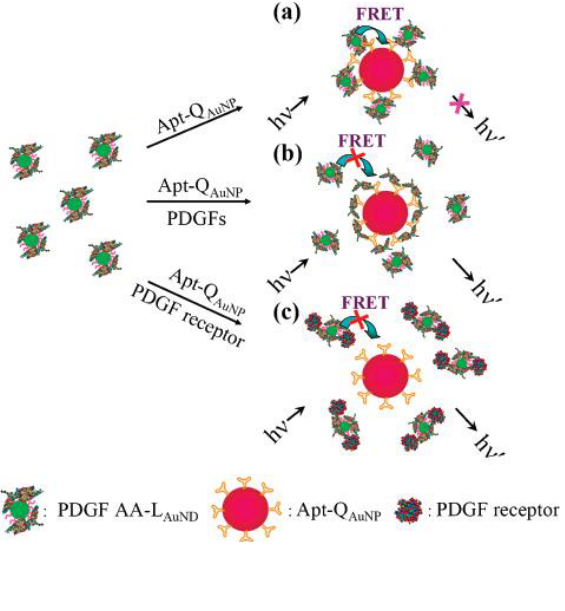
Figure 10. Schematic representations of PFGF and PDGF-receptor nanosensors that operate based on the modulation of the photoluminescence quenching between PDGF AA-Au NP and Apt-Au NP. h: Planck’s constant;  : frequency of light. Reprinted with permission from Reference